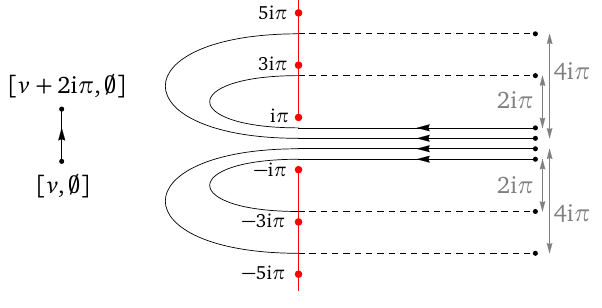
Figure 15: Examples of paths on R which are also closed loops on ˇ R . The solid curves belong to (cid:67) (cid:59) and the dashed lines to (cid:67) , m = 2,1, − 1, − 2 from top to B m